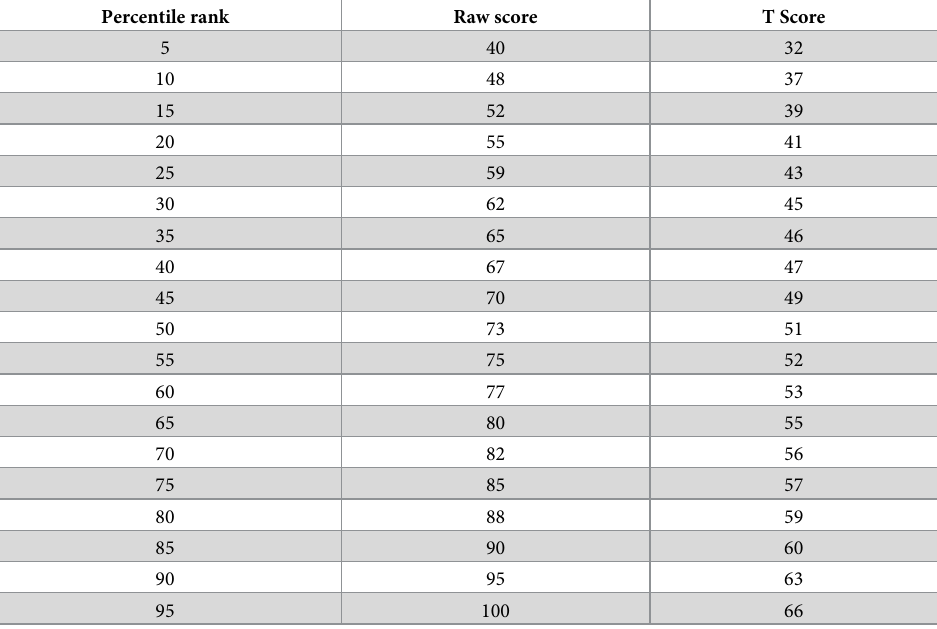
Table 3. Norm table for the Personal Report of Communication